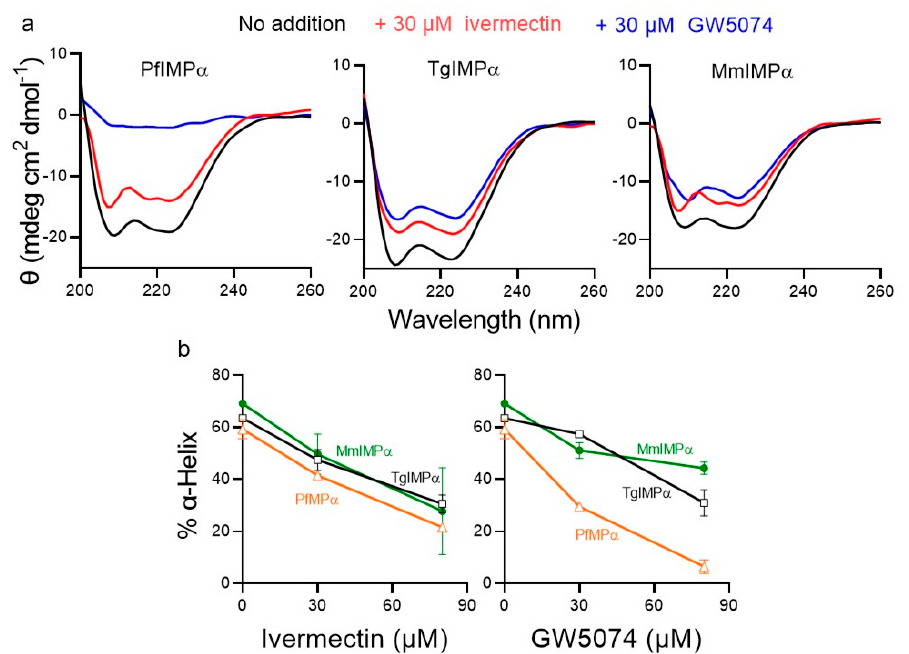
Figure 5. CD spectra for apicomplexan and mammalian IMP α s in the absence and presence of iver- mectin and GW5074. CD spectra were collected for PfIMP α , TgIMP α , and MmIMP α in the absence or presence of 30 µM and 80 µM ivermectin and GW5074. ( a ) Spectra shown are from a single